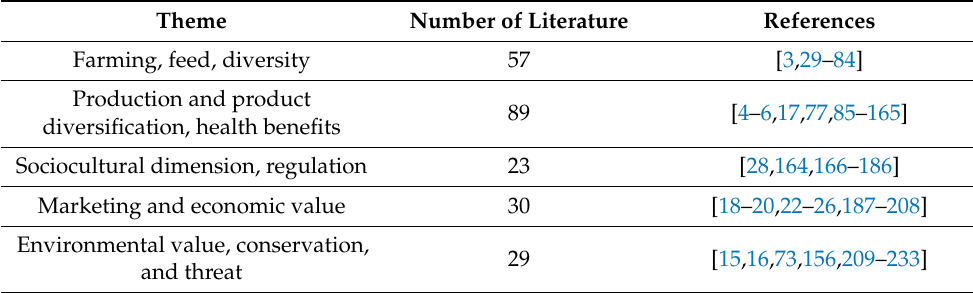
Table 1. Reviewed